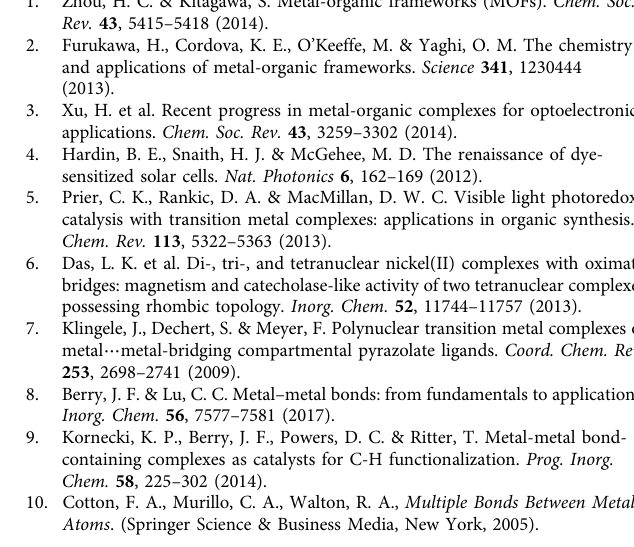
Table 2). The electrostatic potential was modelled as the electrostatic interaction between the DFT-relaxed system (see above) and the quadrupole model density 52 on the probe particle (quadrupole strength Q = − 0.4; stiffness of CO molecule: 0.5 N/m). Discrepancies between simulated and experimental images can be explained by: (i) overestimation of the delocalisation of π electrons by DFT, resulting in fl atter aromatic systems; 53 (ii) omission of long-range background forces in simulations, leading to a low-frequency shift on the substrate; and (iii) underestimation of the interactions between free electron pairs of N atoms of pristine TPPT with the metal surface, leading to bright protrusions in Fig.